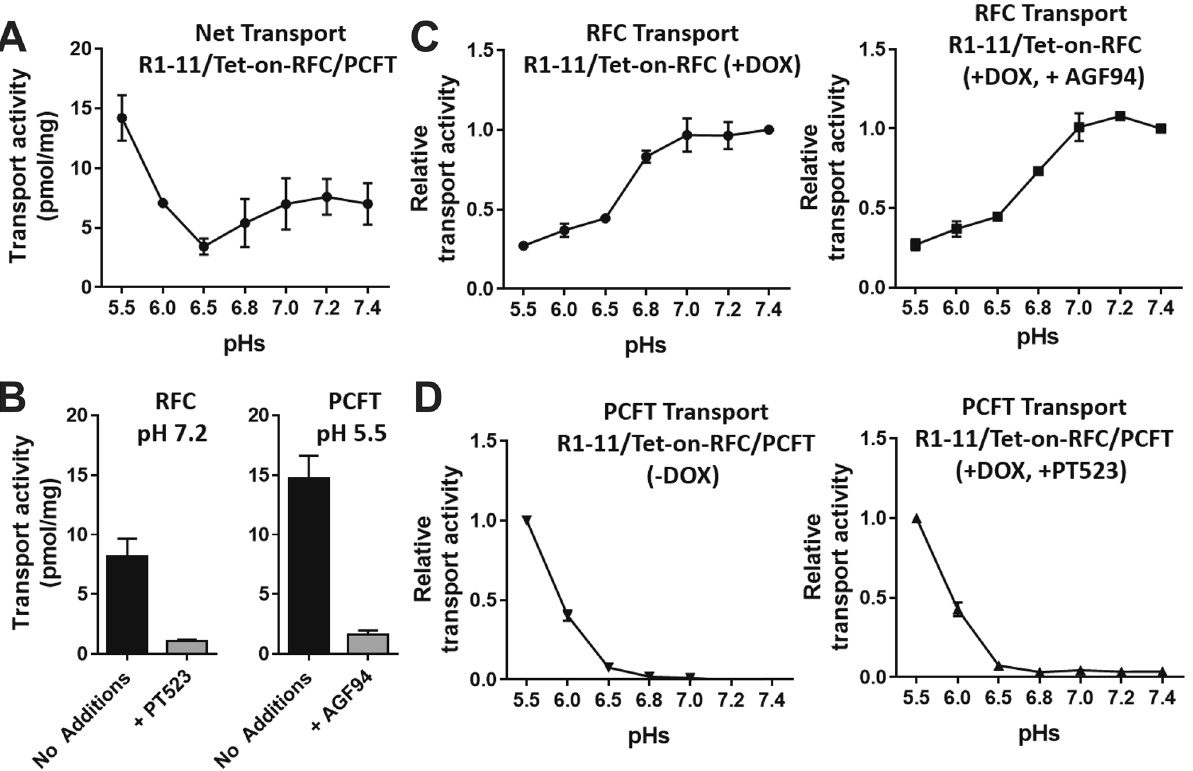
Figure 4. Transport pH profiling of R1-11/Tet-on-RFC single and R1-11/Tet-on-RFC/PCFT double models. R1-11/Tet-on-RFC or R1-11/Tet-on-RFC/PCFT cells were plated in 60-mm dishes in complete FF RPMI 1640 medium containing 10% FBS. Twenty-four hours later, DOX was added at 10 ng/ml. After 48 h, transport was measured over 2 min at 37 °C with [ 3 H]MTX (0.5 µM) in MBS (20 mM MES, 140 mM NaCl, 5 mM KCl, 2 mM MgCl 2 , and 5 mM glucose, for pH 5.5, 6.0 and 6.5) and HBS (20 mM Hepes, 140 mM NaCl, 5 mM KCl, 2 mM MgCl 2 , and 5 mM glucose, for pH 6.8, 7.0, 7.2 and 7.4). The dishes were washed (3×) with ice-cold PBS. The cells were solubilized in 0.5 N NaOH, and the radioactive contents and protein concentrations of the alkaline cell homogenates were determined. Intracellular radioactivity is calculated in units of pmol [ 3 H]MTX per mg of cell protein and results are presented as mean values plus/minus SDs (Panel A, B) or relative values (relative to the maximum activity for each transporter) as mean plus/minus SDs (Panel C, D) from at least 3 experiments. ( A ) Net transport activities of R1-11/Tet-on-RFC/PCFT cells (in the presence of DOX) are shown over a range of pHs. ( B ) The results depict transport activities of R1-11/Tet-on-RFC/PCFT cells at pH 7.2 (optimum for RFC transport) in the absence or presence of 10 μM PT523 (left panel), and at pH 5.5 (optimum for PCFT transport) in the absence or presence of 10 μM AGF94 (right panel). ( C ) RFC transport activities of R1-11/Tet-on-RFC cells (with DOX; left panel) and of R1-11/Tet-on-RFC/PCFT cells (with DOX and in the presence of PCFT specific inhibitor AGF94 of 10 μM; right panel) are shown over a range of pHs. ( D ) PCFT transport activities of R1-11/Tet-on-RFC/PCFT cells (without DOX; left panel) and of R1-11/Tet-on-RFC/PCFT cells (with DOX and in the presence of RFC specific inhibitor PT523 at 10 μM; right panel) are shown over a range of